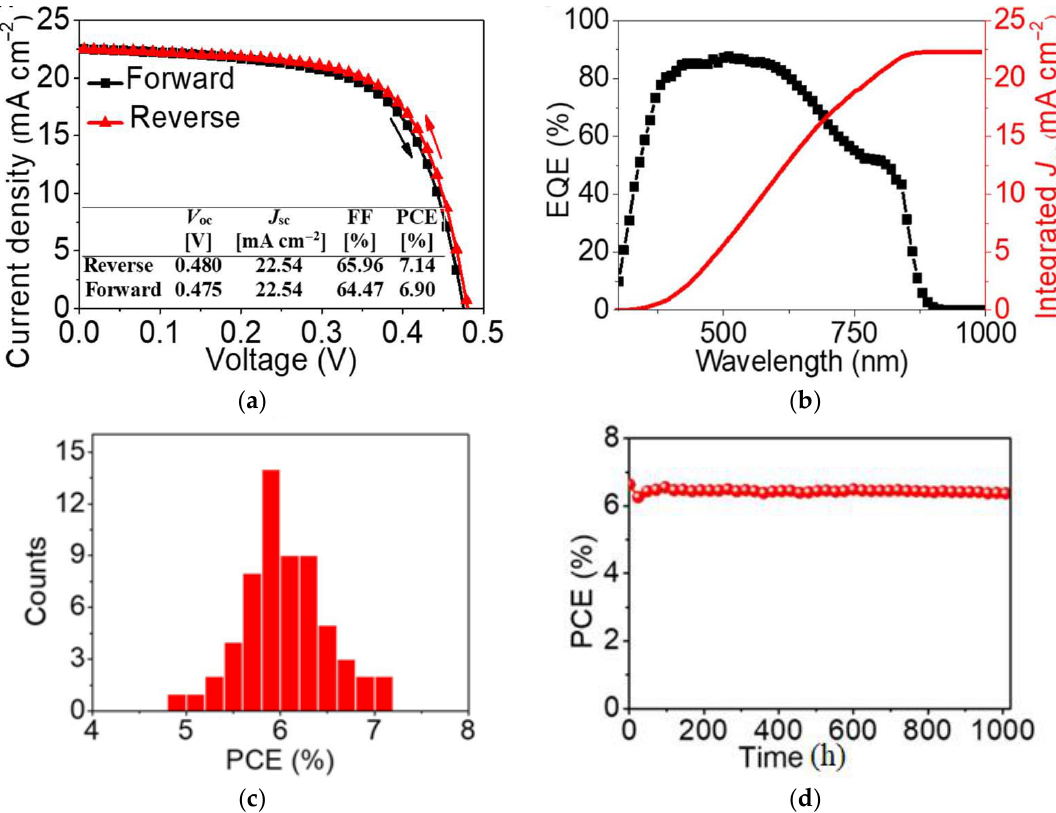
Figure 3. ( a ) Current density-Voltage (Jsc-V) of the cell {en}FASnI 3 perovskite absorber with 10% en loading under reverse and forward voltage scan; ( b ) EQE and integrated Jsc measured from solar cells with 10% en; ( c ) Histograms of power conversion efficiencies (PCEs) for 60% solar cells with 10%; ( d ) The efficiency of an encapsulated device with 10% en as a function of the storage time. Reproduced with permission [41]. Copyright American Asociation for the Advancement of Science, 2017.